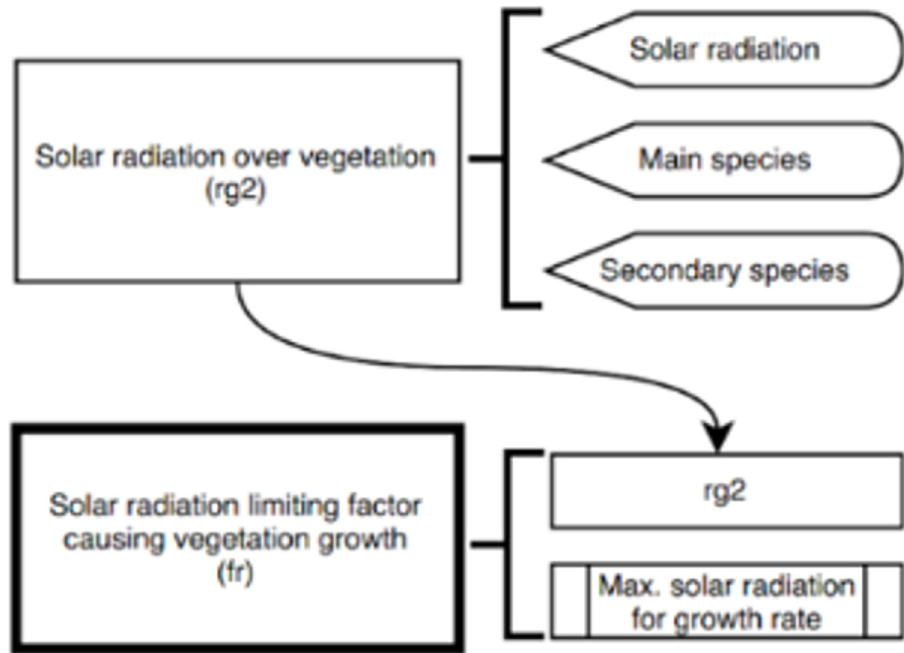
six models are involved in this process.